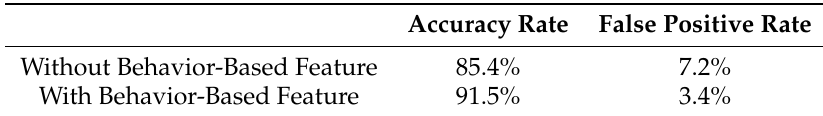
Table 3. Evaluation on effective of behavior-based features.